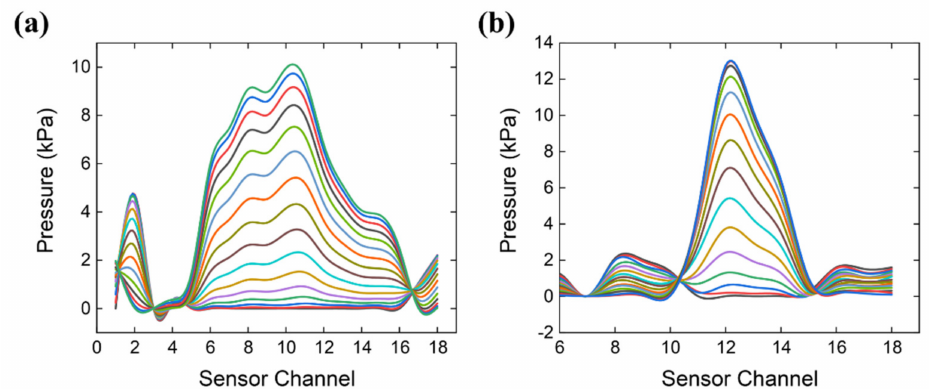
Figure 12. Cross-sectional curve of arterial pulse at different timestamps. Each colored line represents one cross-sectional amplitude curve sampled every six time points during the pulse onset to the percussion peak. The Cross-sectional curve from a subject with ( a ) eight valid sensor channels and ( b ) three valid sensor channels.